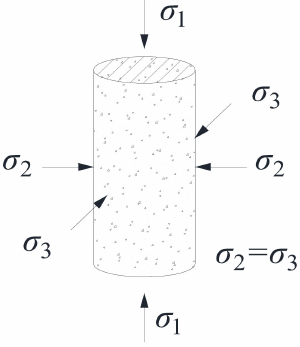
Figure 3. Triaxial stress model of